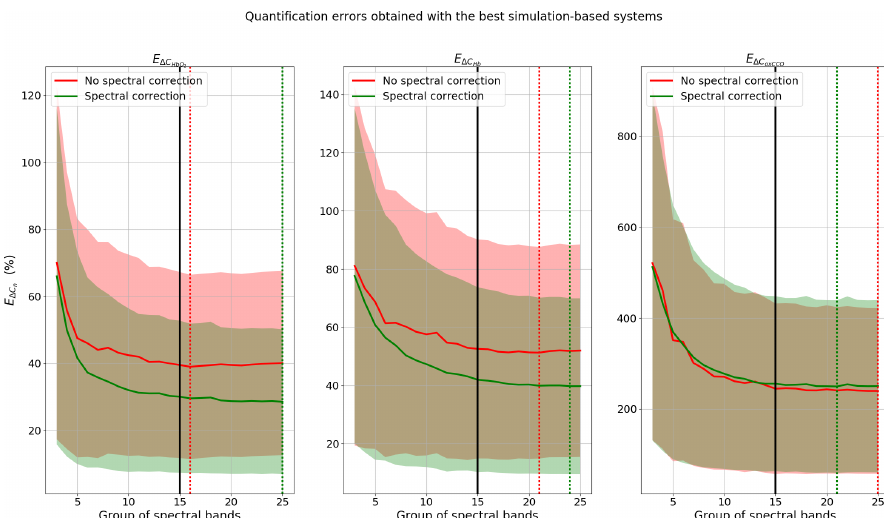
Figure 6. Quantification errors (see Equation (10)) in ∆ C HbO , ∆ C Hb , and ∆ C oxCCO obtained for the best 2 simulation-based deconvolution systems of N spectral bands ( N ∈ [ 3;25 ] ). The solid lines stand for the mean quantification error. The colored areas represent the dispersion range of the quantification errors. The vertical dashed lines indicate the optimal number of spectral bands for the deconvolution of each chromophore. Both corrected (in green) and uncorrected spectral configuration (in red) are